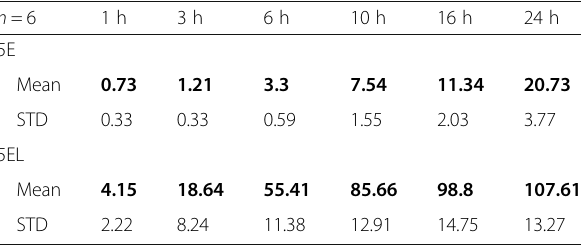
Table 2 The permeation of 5-FU in human hypertrophic scar in vitro at different time points